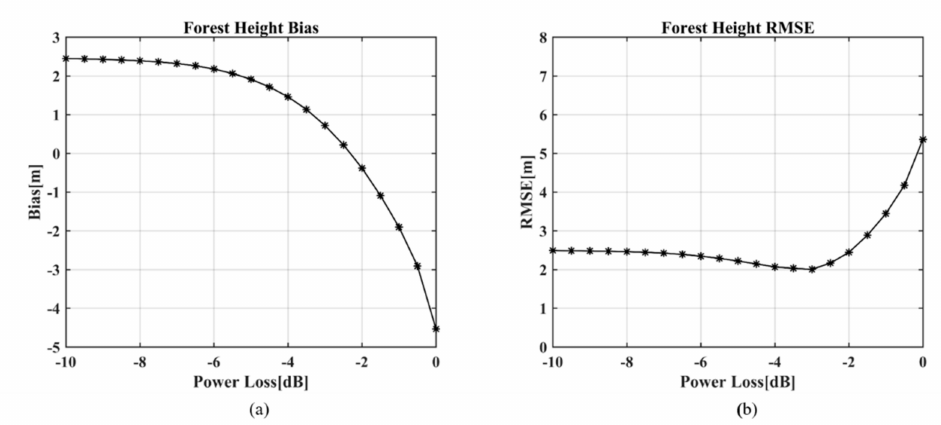
Figure 8. Error of the forest height versus power loss with respect to the phase center elevation: ( a ) bias; ( b )